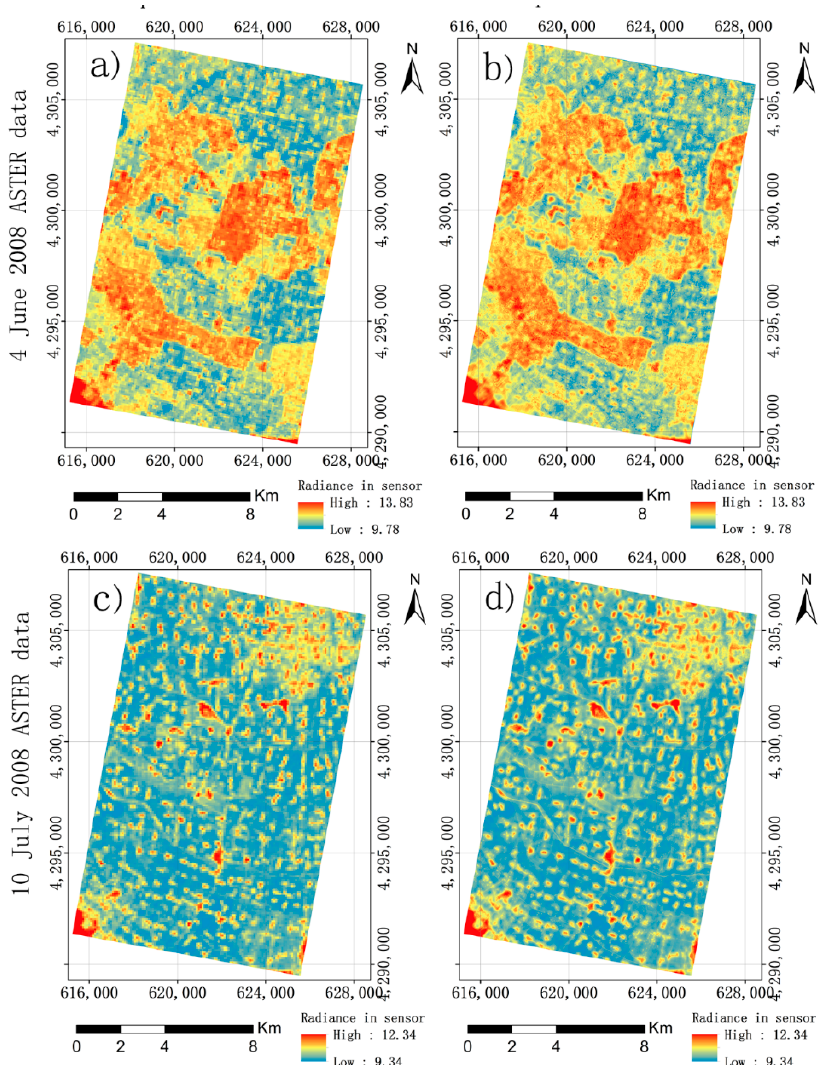
Figure 4. ( a ) and ( c ) the 15 m spatial resolution ASTER-TIR images from 4 June and 10 July 2008 after the data resampled using the nearest neighbor method (NNM); ( b ) and ( d ) the 15 m spatial resolution ASTER-TIR images from 4 June and 10 July 2008 after the data fusion using the discrete wavelet transform (DWT).